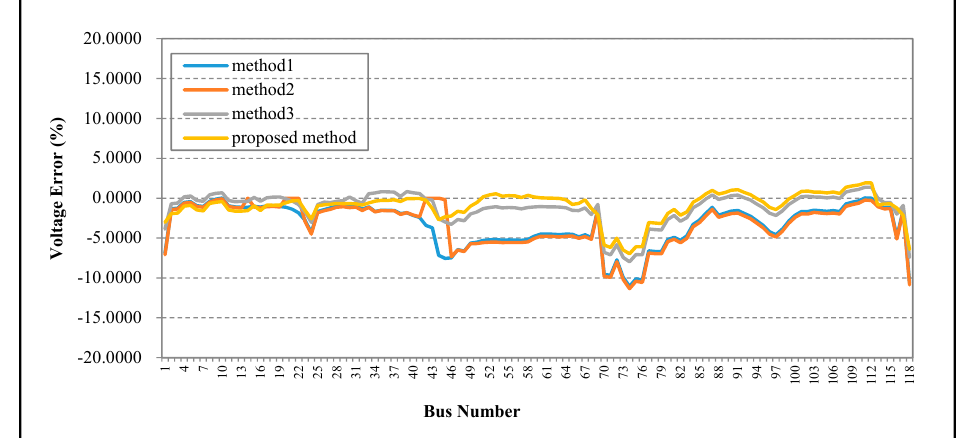
Figure 18. The percentage of voltage amplitude estimate error in 118 bus system.